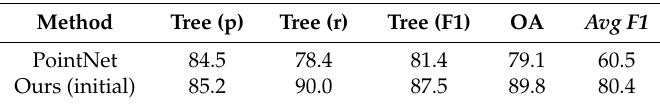
Figure 9. Classification results of the DFC 3D dataset. ( a ) the classification result with PointNet; ( b ) the classification result with the proposed model; ( c ) the ground truth. Table 3. Performance of our model and PointNet on the DFC 3D dataset. We report the precision (p), recall (r), and F1 score for tree category in the first 3 columns as well as the overall accuracy (OA) and average F1 score ( Avg F1 ) in the last two columns (All values are in %).